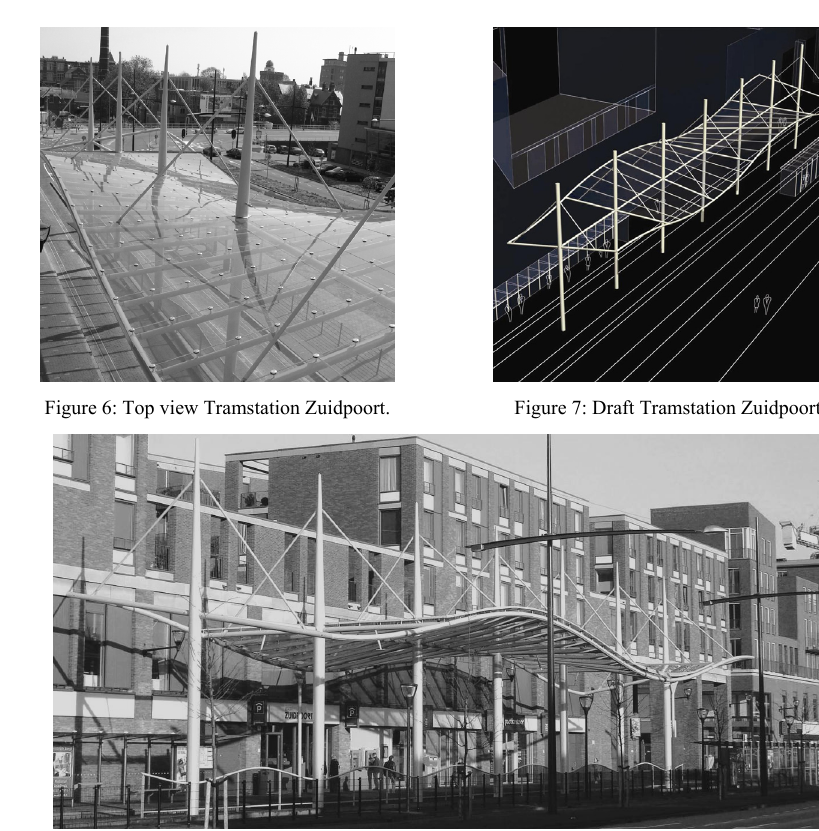
Figure 8: Tramstation